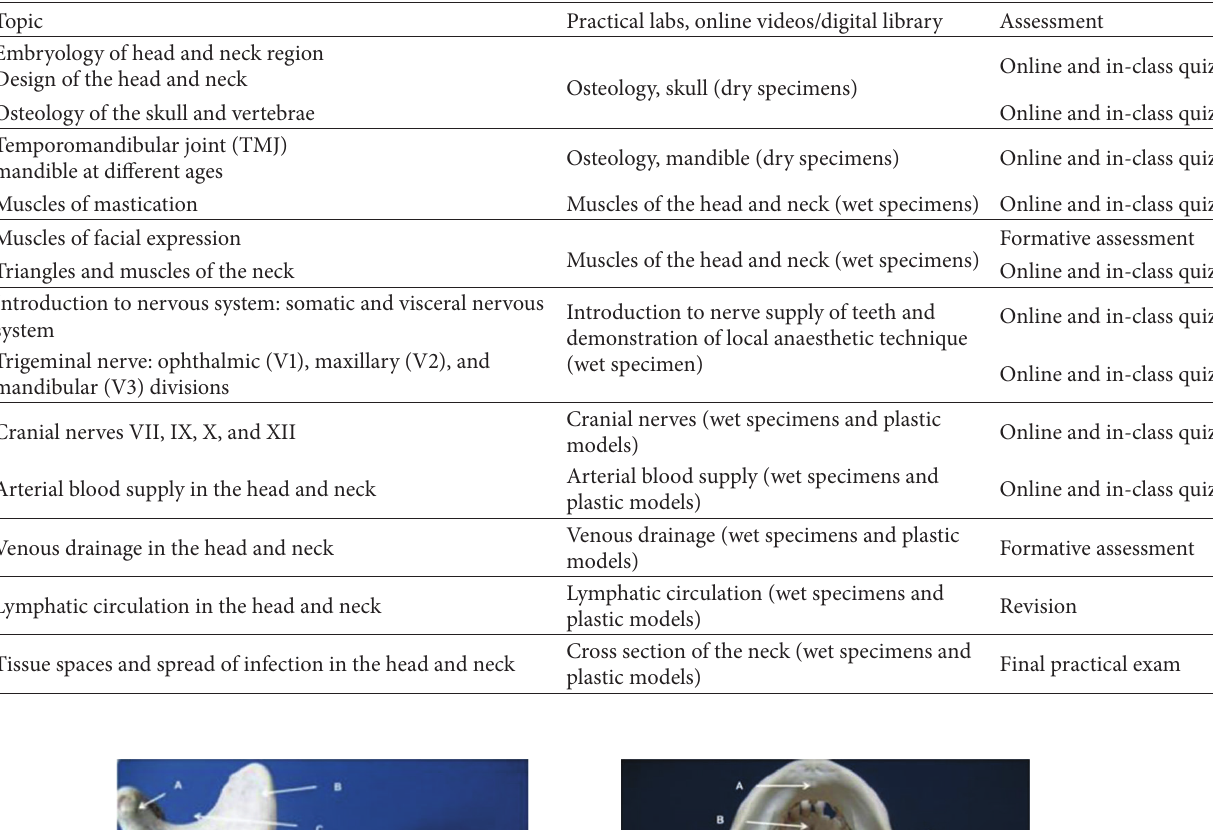
Table 1: A course map for the head and neck anatomy course, identifying curricular knowledge areas, learning environment modalities, and integration of lectures, practical laboratory sessions, and assessment items. Later offerings of the course included access to the online resources/digital library through the Griffith University Blackboard-based learning management system.